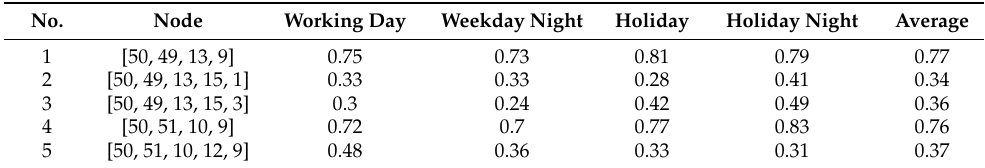
Table 4. Evaluation results for typical scenarios (20